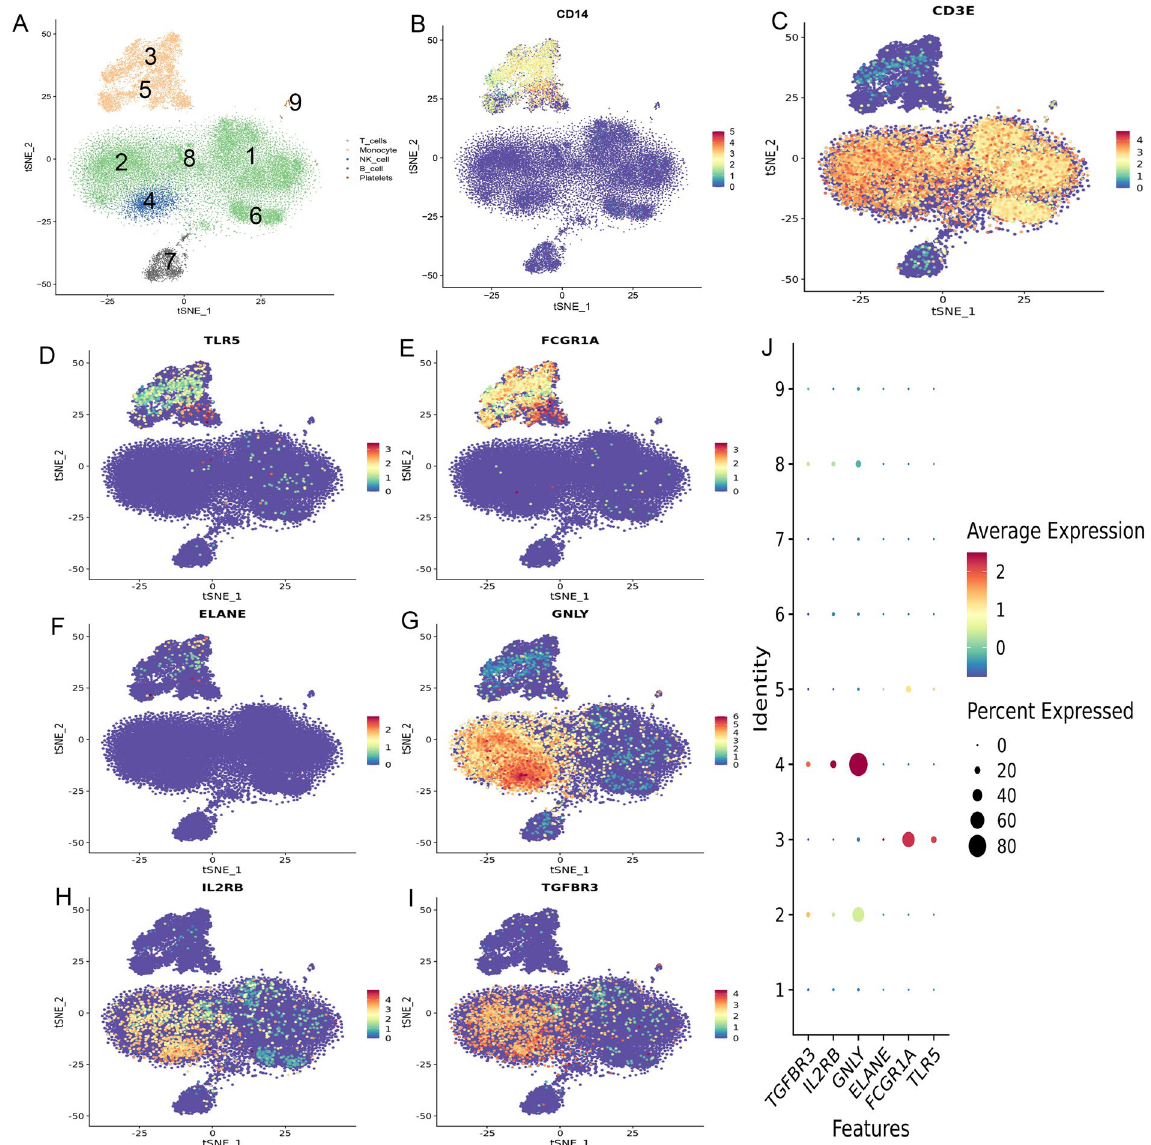
Figure 7. Locations of hub genes in cell clusters. ( A ) Nine transcriptionally distinct cell clusters were distinguished. ( B ) CD14 was the hallmark of monocytes. ( C ) CD3E was a characteristic marker of the NK cells and T cells. ( D – F ) The genes TLR5, FCGR1A and ELANE were distributed in monocytes. ( G – I ) The genes GNLY, IL2RB and TGFBR3 were expressed in NK cells and T cells. ( J ) Bubble plots showing the expression abundance values and ratios of each hub gene in different cell